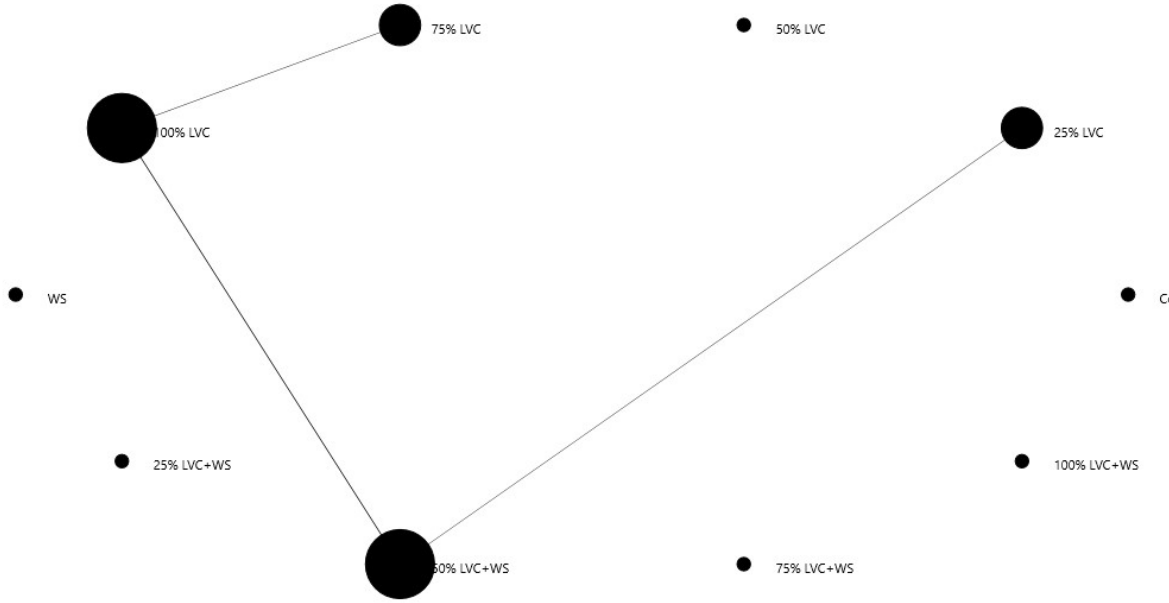
Figure 12. Network plot analysis of phenolics and flavonoids corresponding to the treatments.